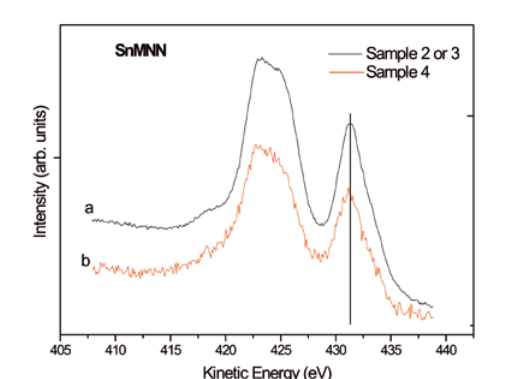
Figure 11. Electron energy loss spectra at E Samples 2, 3 and 4 phase on the top of the craters and at the bottom edge of the mirrors. The tin-rich solid phase would be expected to oxidize after the release of mercury, which causes the softening of the amalgams [8]. The small tin particles with high specific surface area and high porosity in the samples produced by mercury release facilitated the oxidation of the bulk of the amalgam